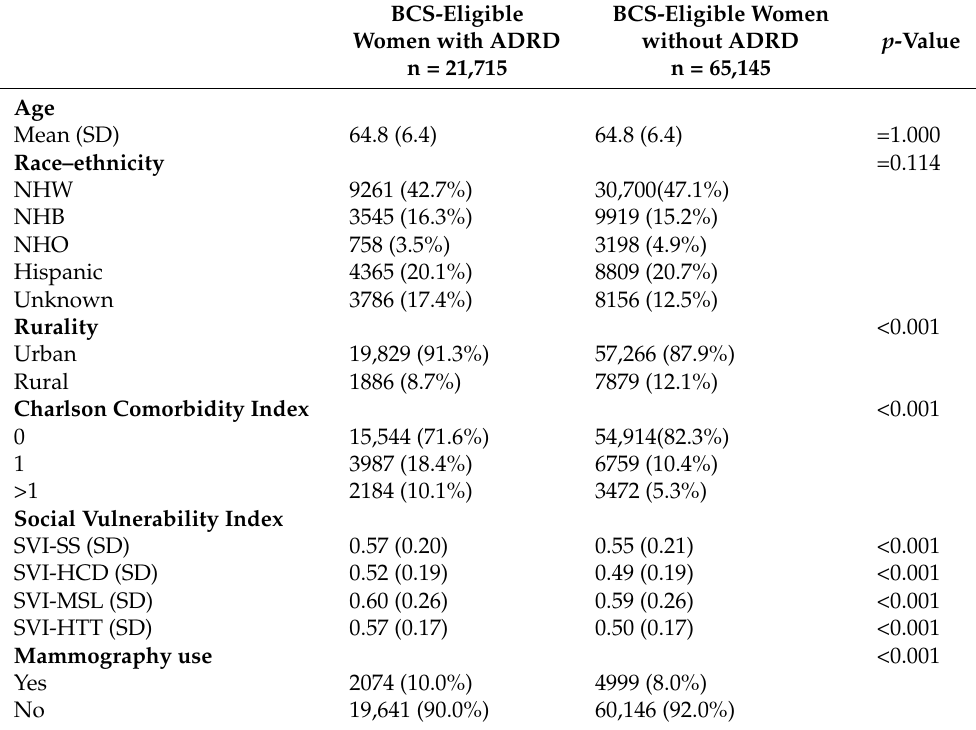
Table 1. Characteristics of the study